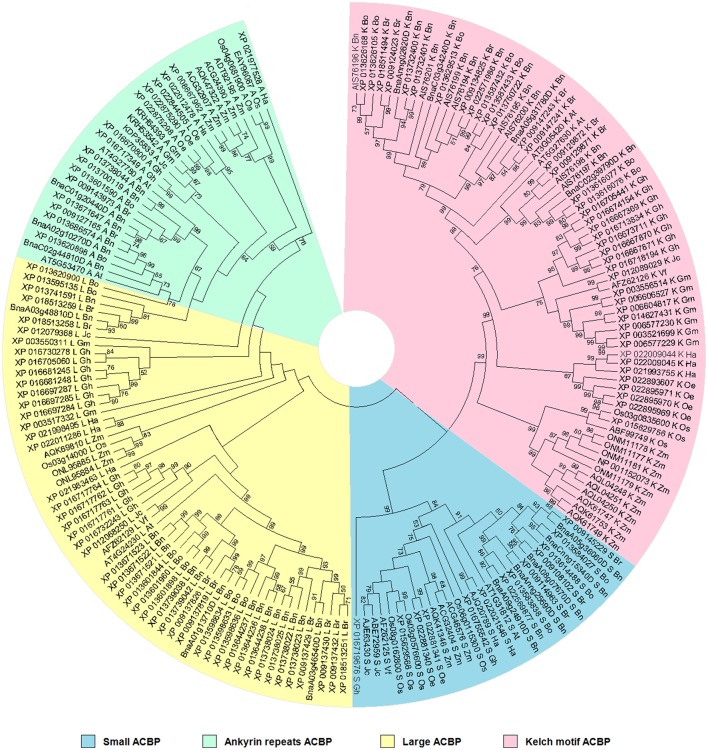
Phylogenetic relationships of oil crops, based on ACBP. The tree was inferred using the Neighbor-Joining method (Saitou and Nei, 1987). The evolutionary distances were computed using the p-distance method (Nei and Kumar, 2000) and are in the units of the number of amino acid differences per site. The analysis involved 186 amino acid sequences. ACBP families were clustered into four classes, indicated by different colors. Evolutionary analyses were conducted in MEGA7 (Kumar et al., 2016).